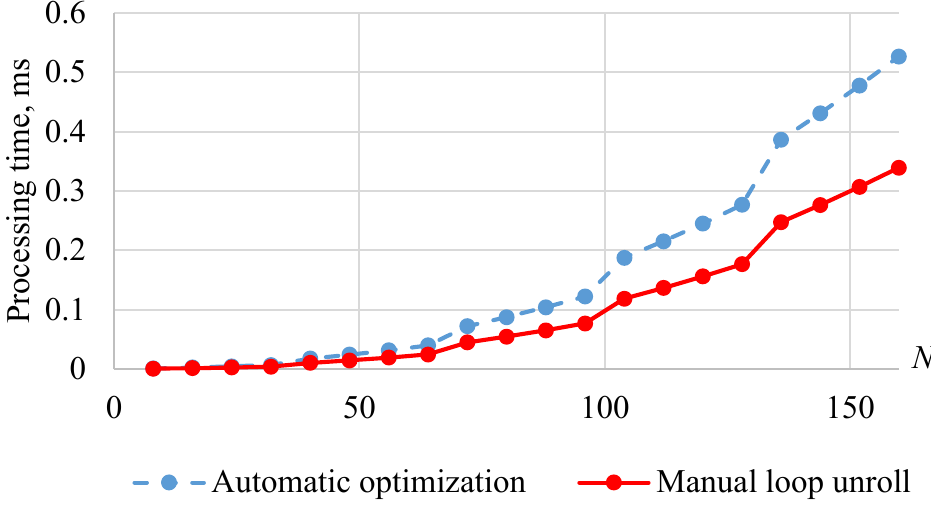
Figure 7. Processing time for matrix multiplication of 16-bit unsigned integers with automatic and manual loop unrolling.